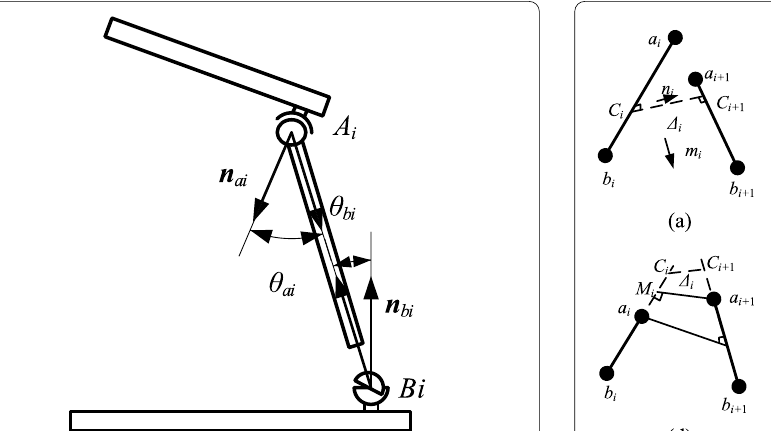
Figure 10 Setting of the rotation angle